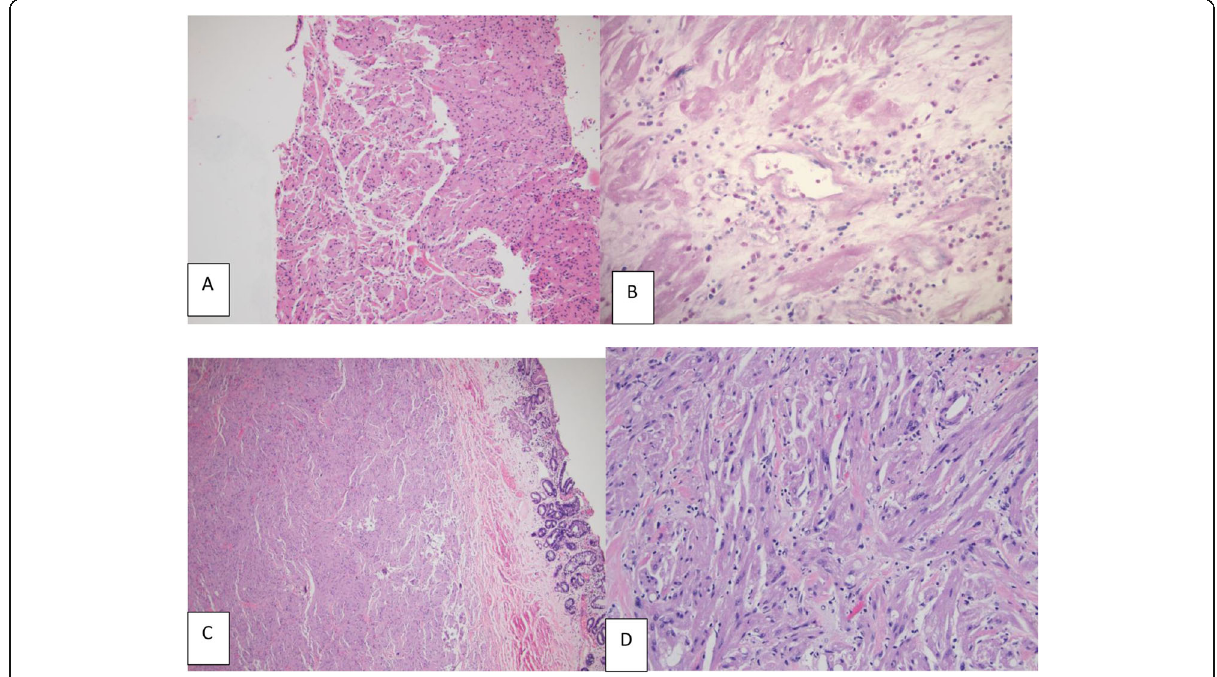
Fig. 1 A , Incidental eGCT in an EoE patient with minimal atypia and lack of intralesional eosinophils (hematoxylin and eosin stain [H&E] at 100x). B , Atypical eGCT with significant intralesional eosinophilia (Geimsa histochemical stain at 200x). C , D , Biopsy from a Barrett esophagus and eGCT showing overlying epithelium with goblet cell metaplasia (H&E at 40x) and atypical GCT with areas of spindling, pleomorphism, increased nuclear size and prominent nucleoli (H&E at